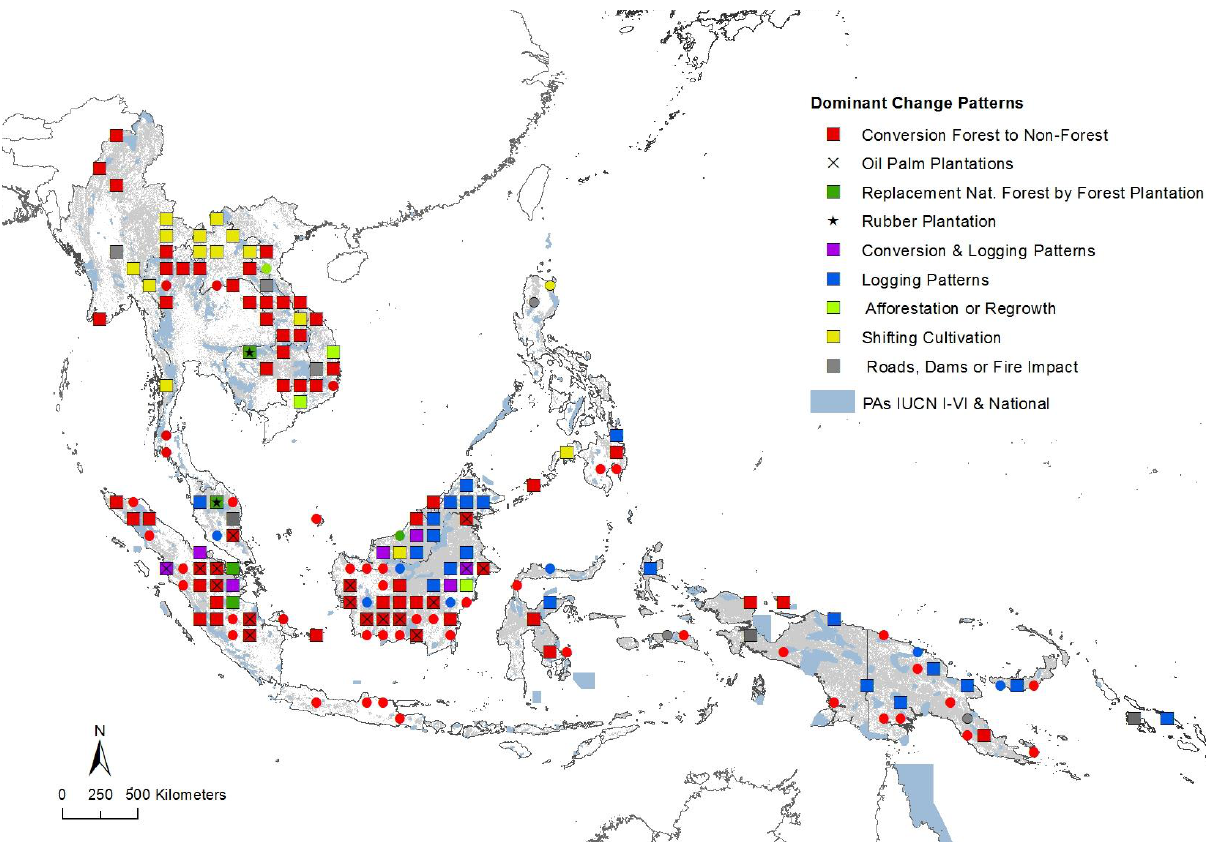
Fig. 4. Dominant patterns of forest change types as visually identified from satellite imagery within the sample units. Squares: 2000–2010 patterns. Circles: 1990–2000 patterns. Background map (grey): Forest Cover 2000.